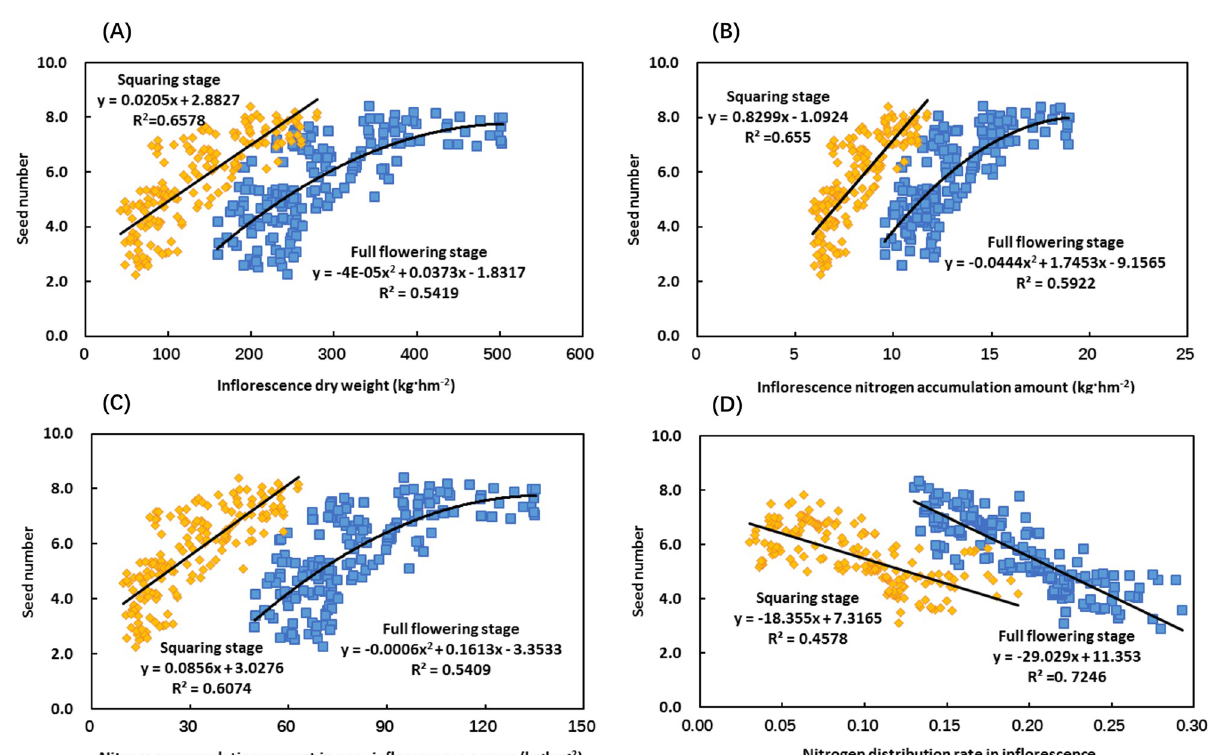
Fig 4. Relationships of seed number with dry matter, nitrogen accumulation and the proportion of nitrogen distribution in inflorescence organs, nitrogen accumulation in non-inflorescence organs in Chinese milk vetch. Relationship between seed number and dry weight, nitrogen accumulation amount and nitrogen distribution rate in inflorescence organs of Chinese milk vetch (n = 180, A, B and D, respectively), and relationship between seed number and nitrogen accumulation amount in non-inflorescence organs of Chinese milk vetch (n = 180, C). Yellow symbols represent the squaring stage, and blue symbols represent the full flowering stage. All the experiments are